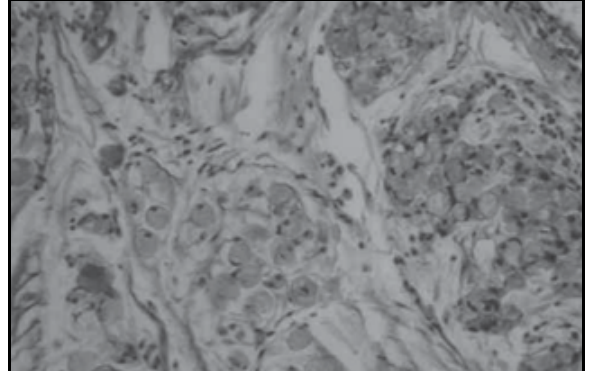
Figura 1 – Expressão citoplasmática de MUC5AC no epitélio metaplásico de Barrett e no epitélio colunar superficial em biópsia após FN (250×) FN: fundoplicatura de Nissen.